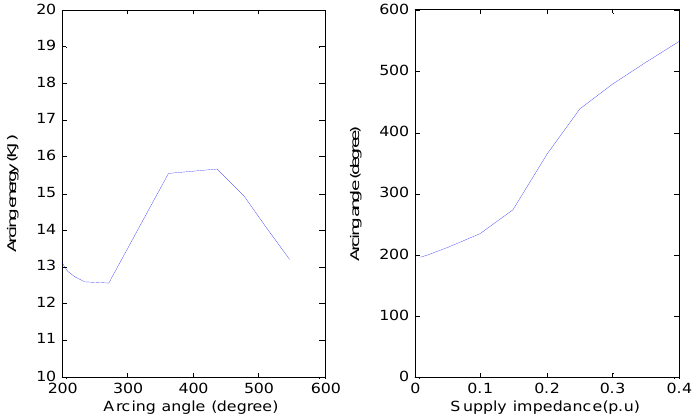
Figure 11. Variation of the arc energy versus arc-angle and arc-angle versus the DC machine HP when the 200 A fuse used as